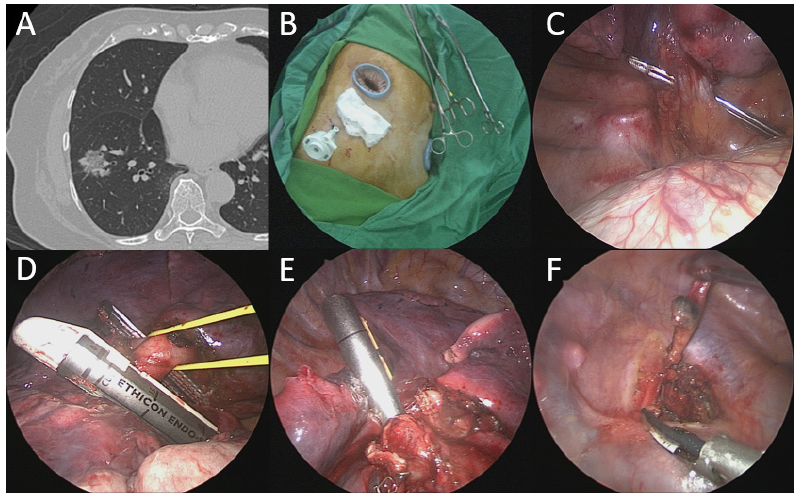
Figure 3. Postoperative view of subxiphoid and intercostal incision. All subxiphoid and intercostal incisions and drains were equal in length and size, regardless of whether they were used in bilateral uniportal VATS ( A ) or unilateral multiportal VATS ( B ). formed depending on surgical procedure type (See Figure 4 and Table 2).